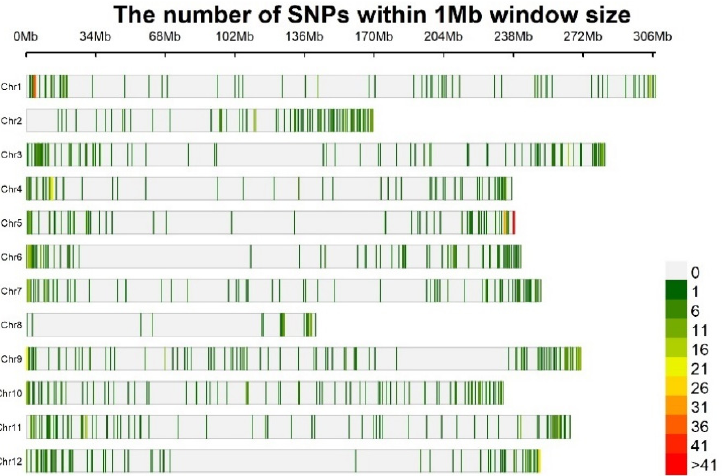
Figure 5. Distribution of 2196 SNPs on the 12 pepper chromosomes. The number of SNPs is repre ‐ sented within 1 Mb window size. The horizontal axis shows the chromosome (Chr) length (Mb); each bar represents a chromosome, with Chr 1 at the top and Chr 12 at the bottom. The different colours depict SNP density following the gradient in the legend on the right.